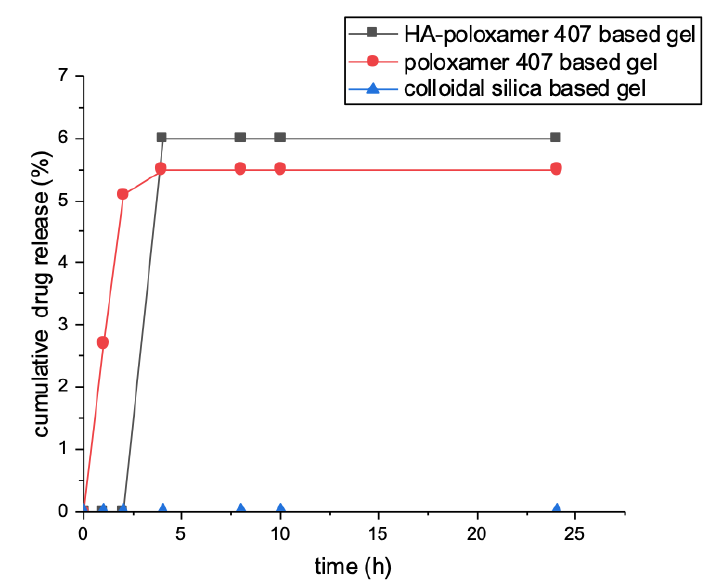
Figure 4. Cyclosporine release profile evaluated within 24 h.